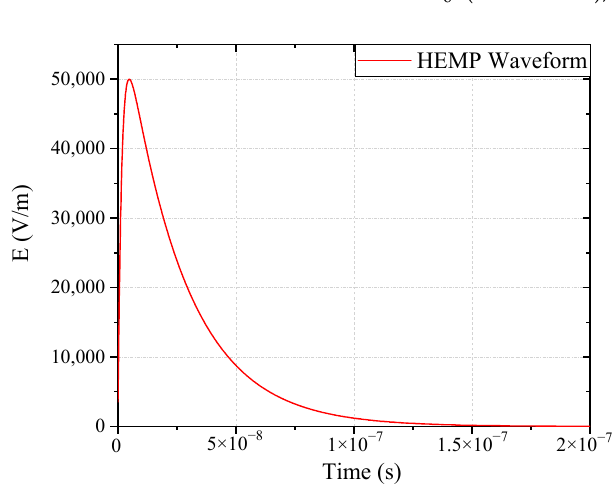
Figure 2. Time domain waveform of HEMP (E1 period).